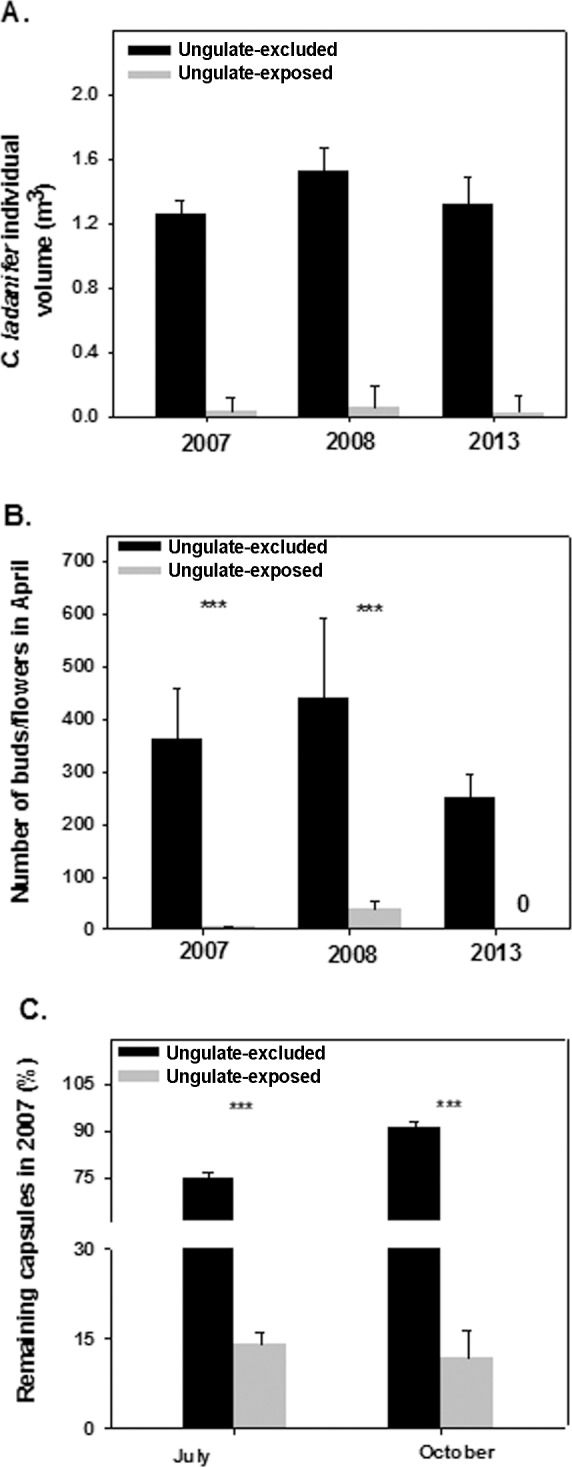
Model-adjusted means (± 1 SE) of A) Cistus ladanifer volume per individual in 2007, 2008 and 2013 B) Numbers of flower buds (plus open flowers) produced during 2007, 2008, and 2013 seasons in ungulate-excluded and ungulate-exposed (open) plots and C) Percentages of remaining capsules in July (regarding flower bud number in April) and October 2007 (regarding capsule number in July). (***, P < 0.001)